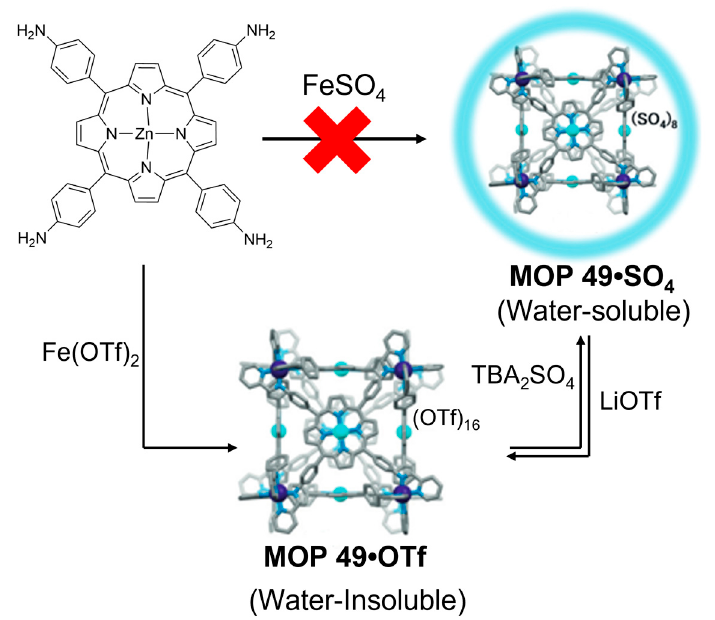
Figure 20. Subcomponent self-assembly of MOP 49 • OTf and reversible anion exchange to obtain the water-soluble derivative MOP 49 • SO 4 . Reprinted by permission from Ref. [76]. Copyright 2017 from Wiley-VCH.